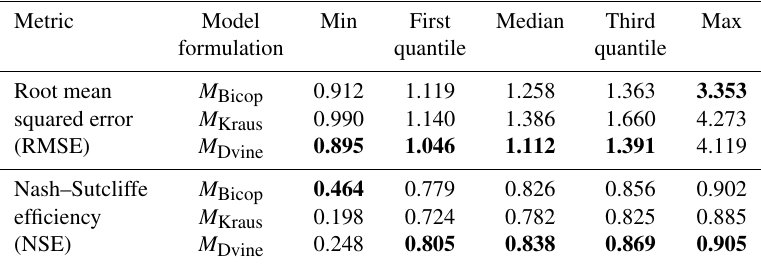
Table 2. RMSE and NSE results over the validation periods under the synthetic experiment for comparing copula-based model formulations. The best metric values for each quantile are shown in bold. Metric Model Min First Median Third Max formulation quantile Root mean